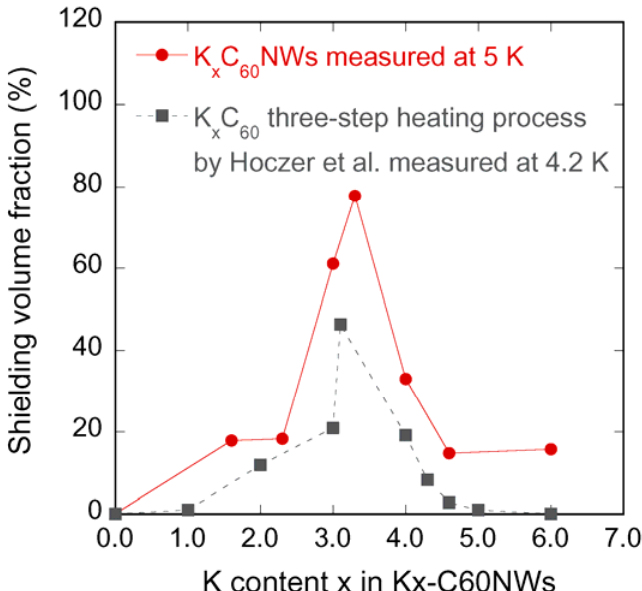
C NWs (at 5 x 60